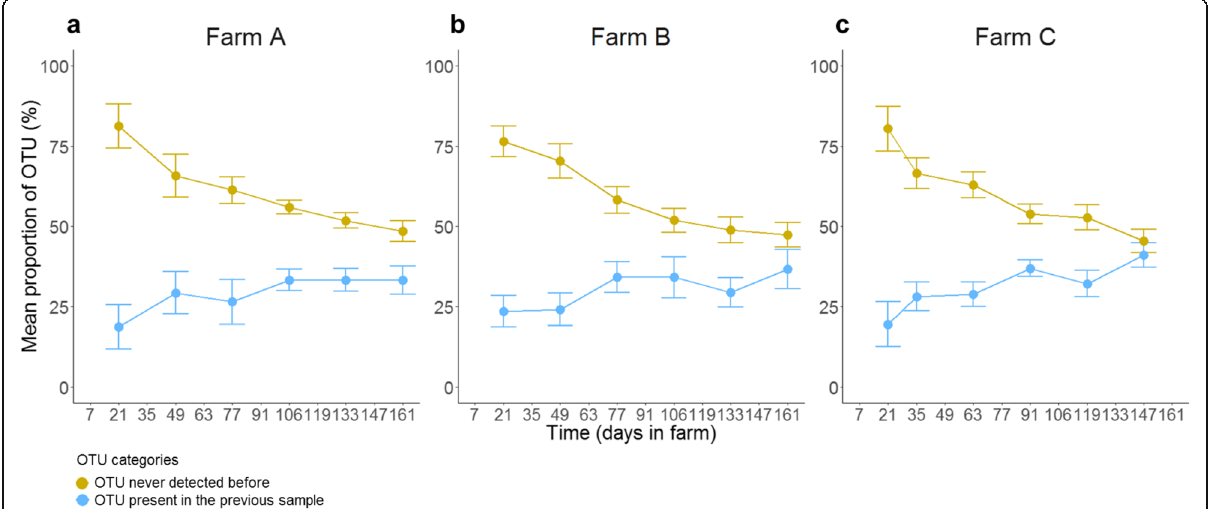
Fig. 5 Mean proportion of OTUs relative to those detected in previous samples of the same calf. The mean proportion of OTUs for farm A, farm B, and farm C are represented in panels ( a ), ( b ), and ( c ), respectively. The mean proportions ± standard deviations of the data are represented by the bars